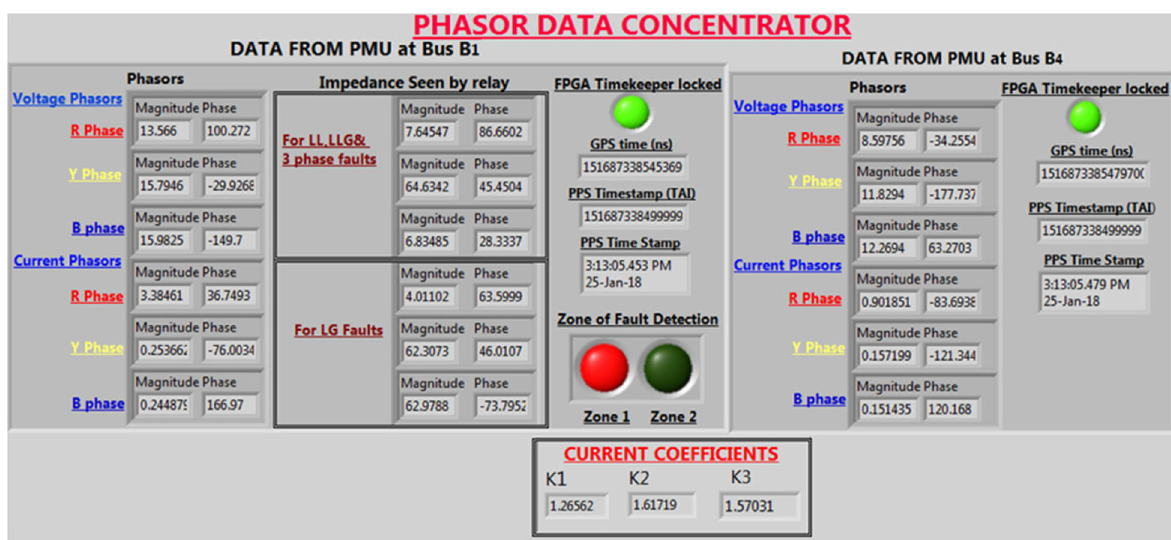
Fig. 14 LabVIEW front panel display of PDC at SPC showing the performance of distance relay R A with the proposed PAZSD methodology for an LL fault (FR = 1.7 Ω ) at 250 km from B 1